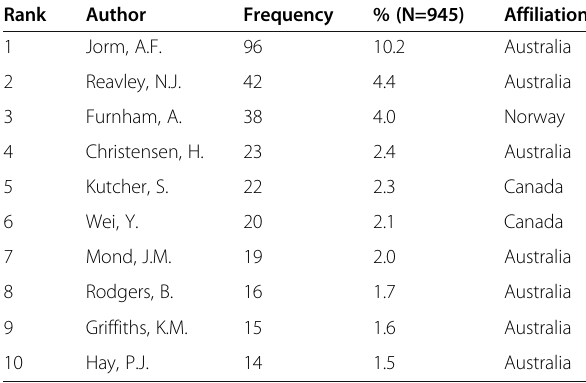
Table 4 Top ten active authors in publishing research documents on mental health literacy